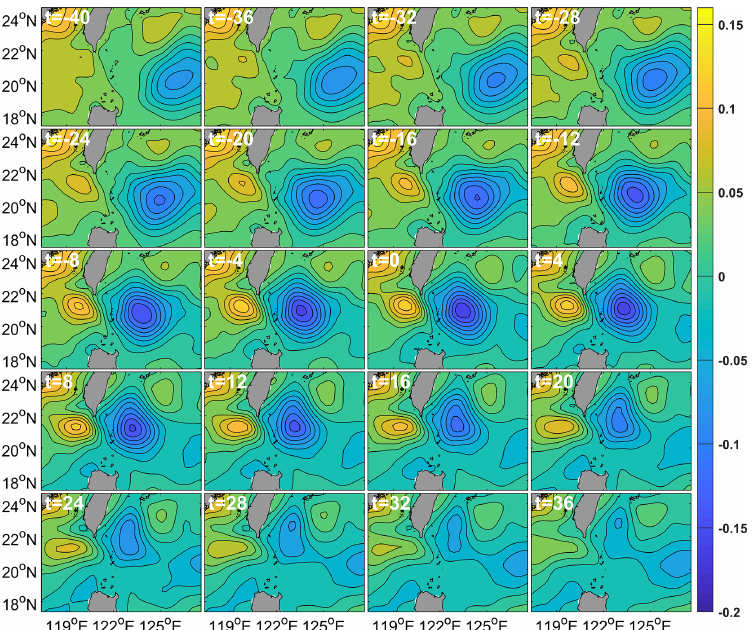
Figure 10. Evolution of CE mode of counter-rotating eddy pair in LS based on CMEMS data. Contours and shading both represent SSHA (units of m). SSHA interval is 0.02m. t in the top left-hand corner of each panel denotes days before (negative value) or after (positive value) the CE mode of counter-rotating eddy pair reached the maximum ( t = 0). t = 0 corresponds to time of Fig. 3b.